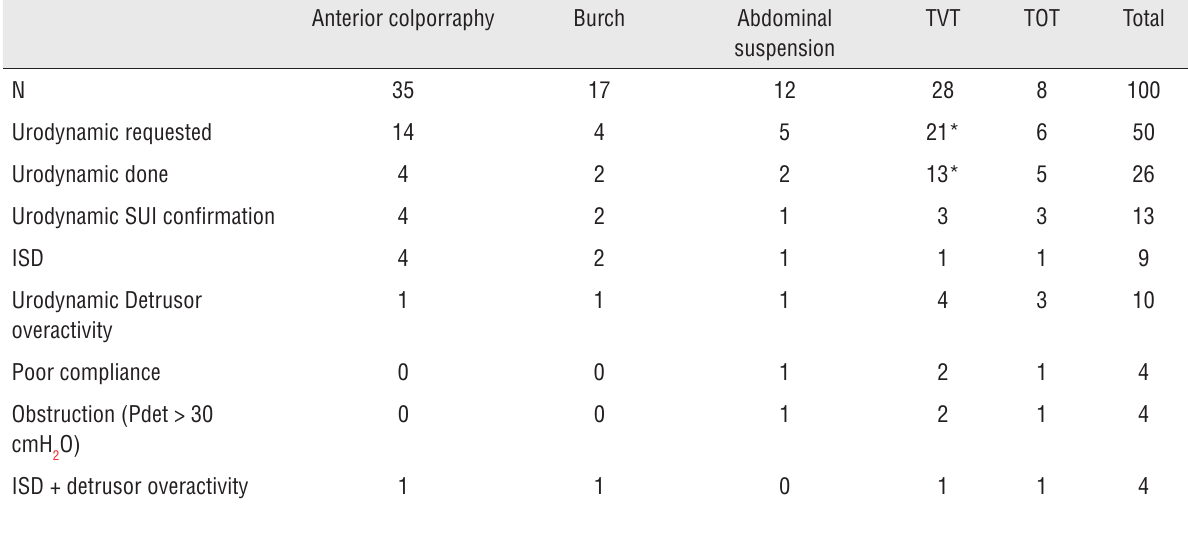
Table 3 – Results of the urodynamic evaluation requested after ascertainment of clinical failure of the SUI